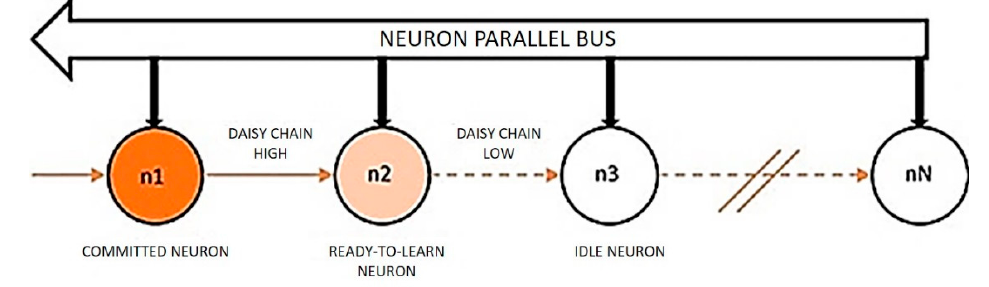
Figure 3. SNN layout showing neurons connected in a daisy chain.